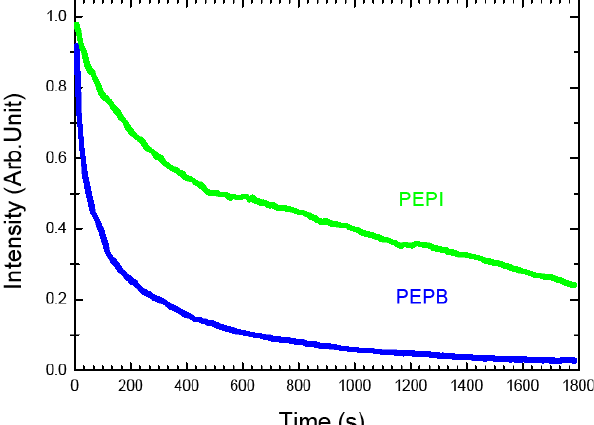
Figure 4. Evolution of PL intensity as a function of illumination time for PEPI, PEPB thin films. The samples are excited with the 325 nm line of a HeCd laser at 7 mW (corresponding to a fluence 0.175 W·cm −2 ) in air. The PL intensities are normalized to 1 at t = 0